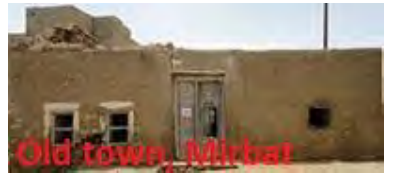
Figure 6. Fac¸ade’s photograph building